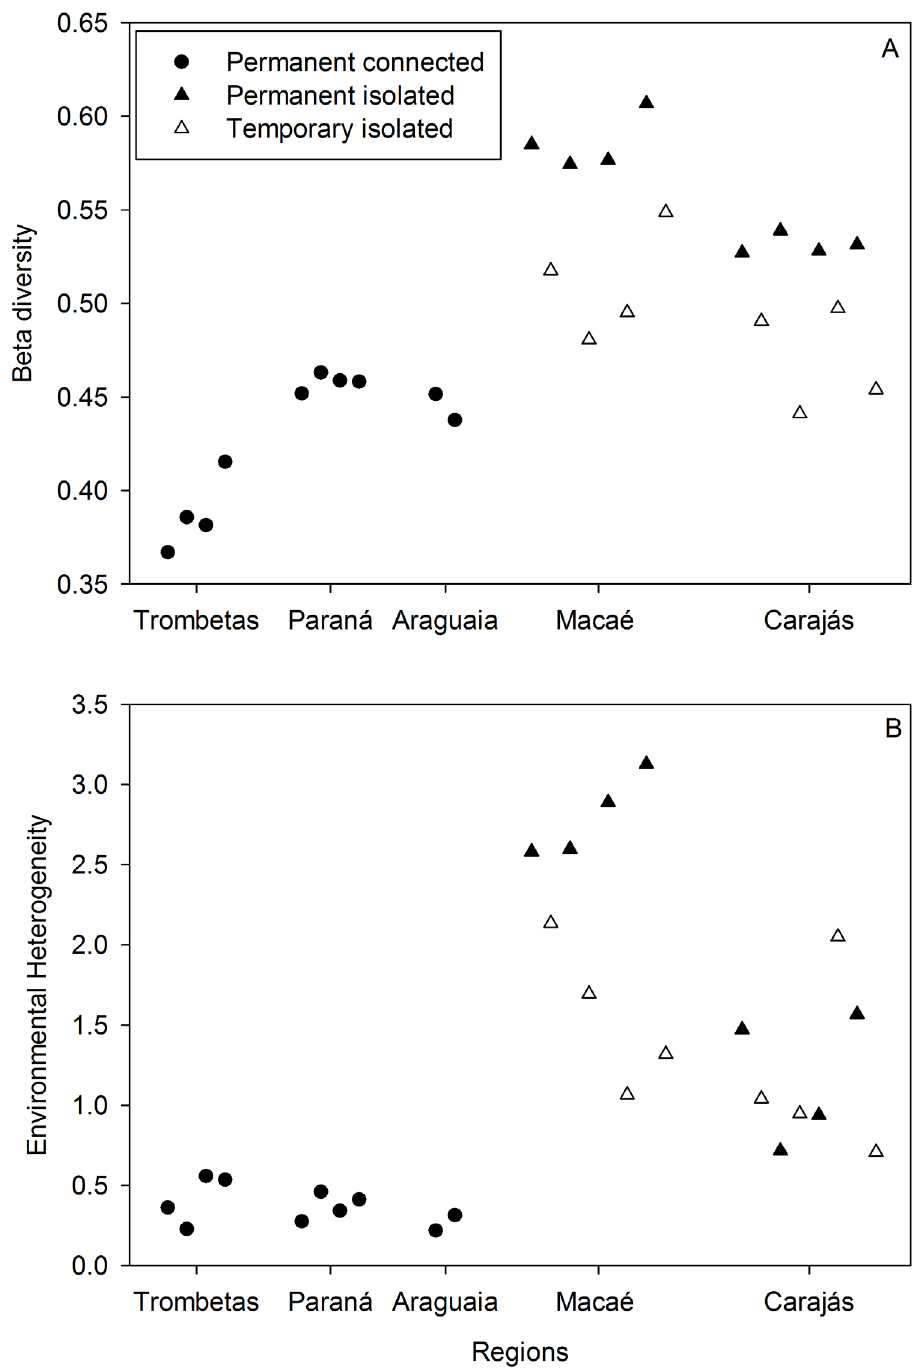
Figure 1. Zooplankton beta diversity for each studied region. (A) Zooplankton beta diversity (as the mean Jaccard distance to group centroid) for each region, sampling time (for each region, the different data points in the X-axis represent the different sampling times) and lake categories (permanent connected, permanent isolated and temporary isolated). (B) Environmental heterogeneity for each region, sampling time and lake categories.